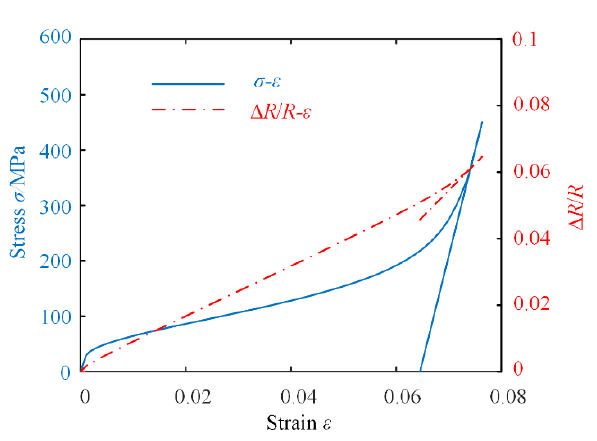
Figure 5. The relationship between σ - ε and σ -Δ R / R at 25 °C.